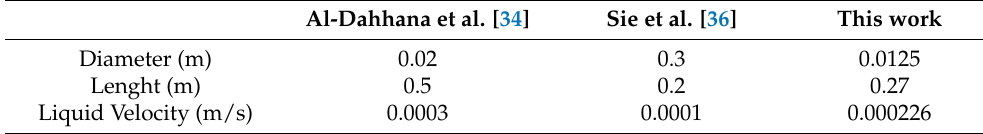
Table 4. Bench-scale trickle bed reactor standard measurements in experimental